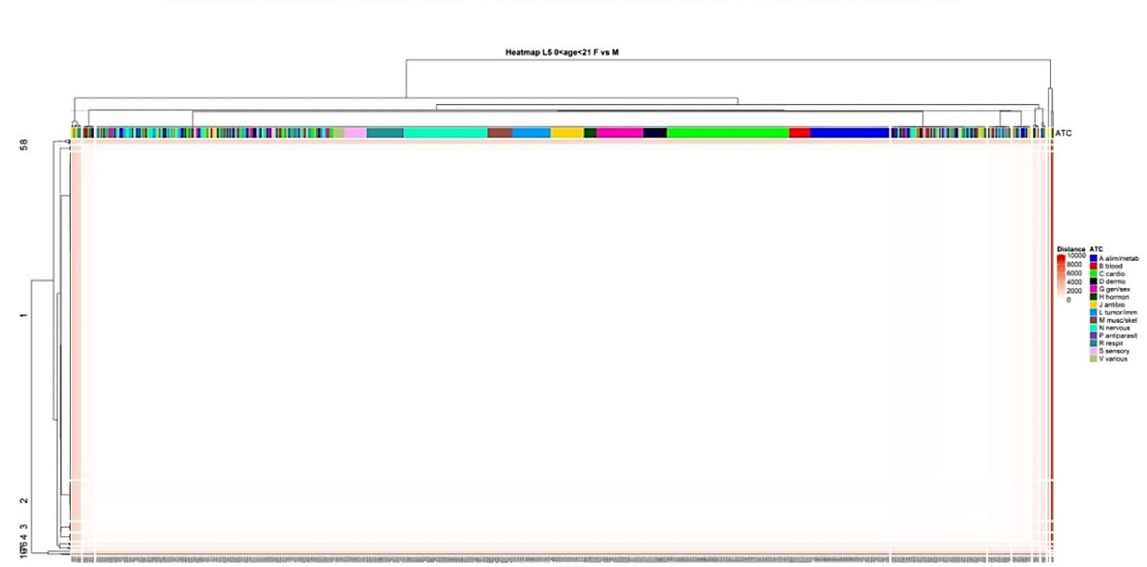
Figure A8. Distance matrices for three ATC levels to compare females vs. males at the 0–21 years age strata. The colour in entry ( 𝑖 , 𝑗 ) is the Euclidean distance between layers 𝑖 (females) and 𝑗 (males) of the binary DPN. Euclidean distances are coded by colours from white (small distance) to red (large distance). Nodes are coloured according to the 14 groups found at the first level of the ATC classification system. Dendrograms identify a number of clusters in the distance matrices.